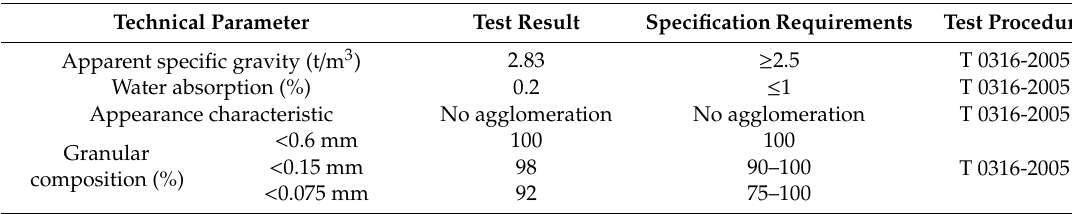
Table 4. Technical parameters of mineral